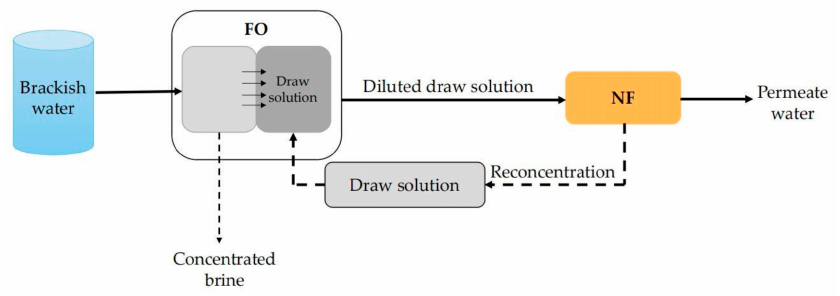
Figure 10. Schematic diagram of FO–NF system.